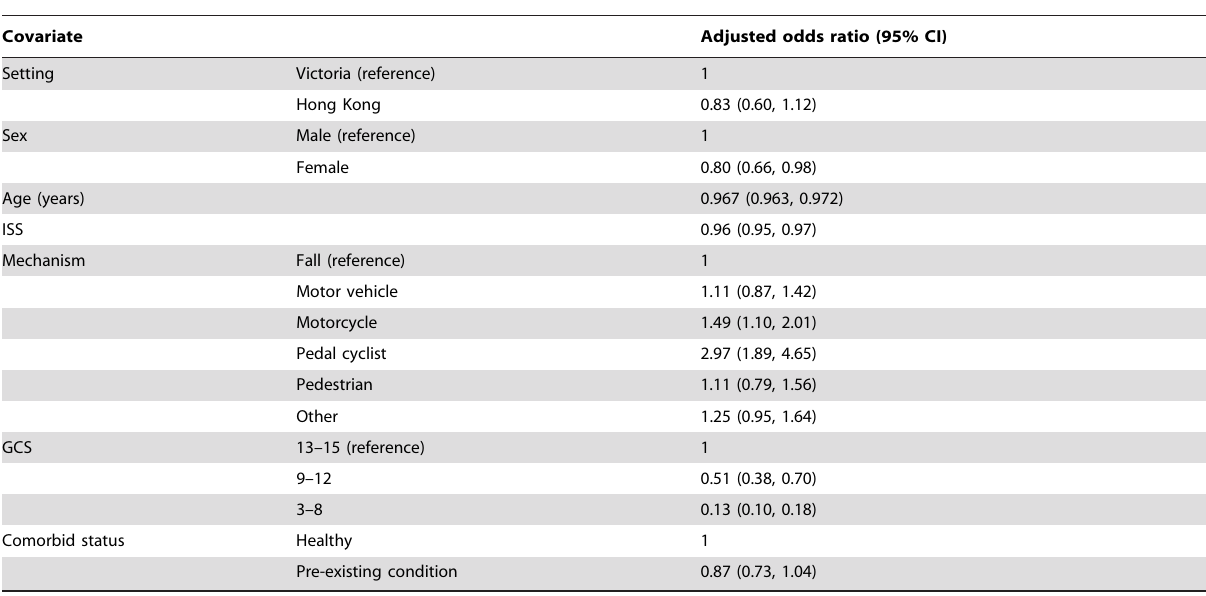
ISS: Injury severity score. GCS: Glasgow Coma